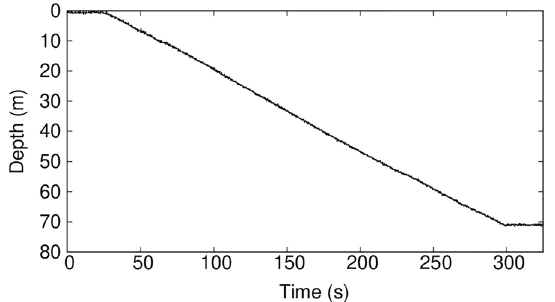
Fig. 17 Depth data for the robot diving to the lake bottom